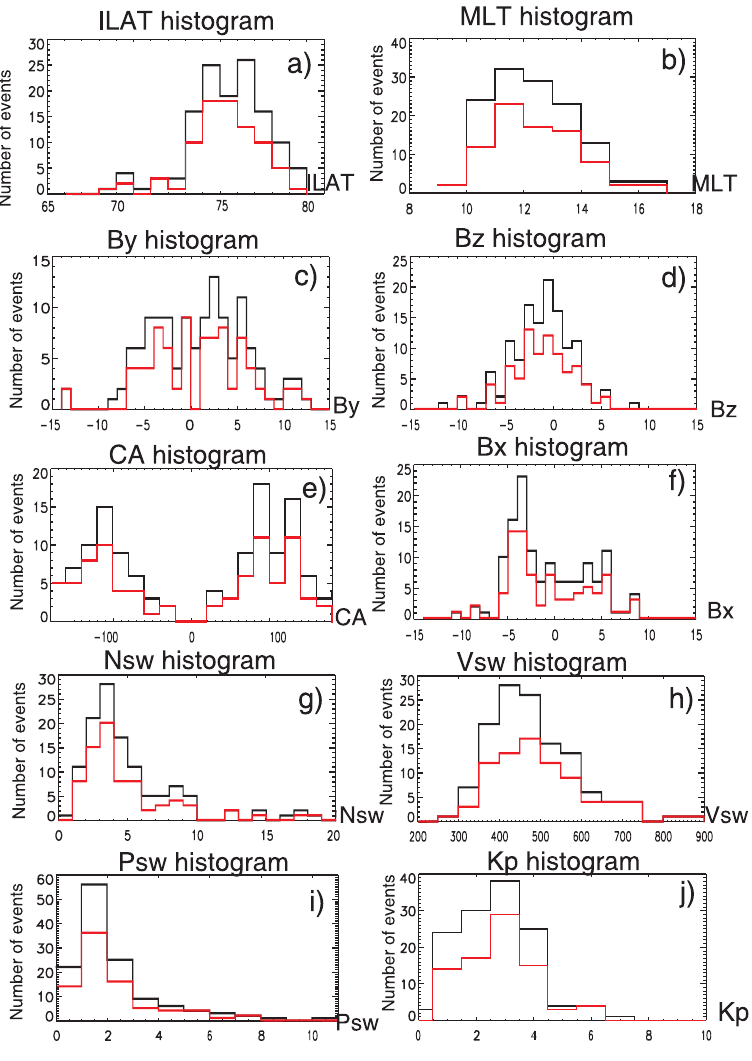
Fig. 5. Properties of the available data set in the form of histograms showing how many events were observed under different conditions: the invariant latitude of observations (panel a ), the magnetic local time of observations (panel b ), the IMF B Y -component and B Z -component (panels c and d , correspondingly), the IMF clock-angle (panel e ), the IMF B X -component (panel f ), the solar wind density (panel g ), the solar wind velocity (panel h ), the solar wind dynamic pressure (panel i ), and index of geomagnetic activity K p (panel j ). The GSM coordinate system has been used. The plots each show the total number of events in each bin (black lines) and the number of those events for which the multi-spacecraft technique for the estimation of the LLBL electron edge size could be employed (red